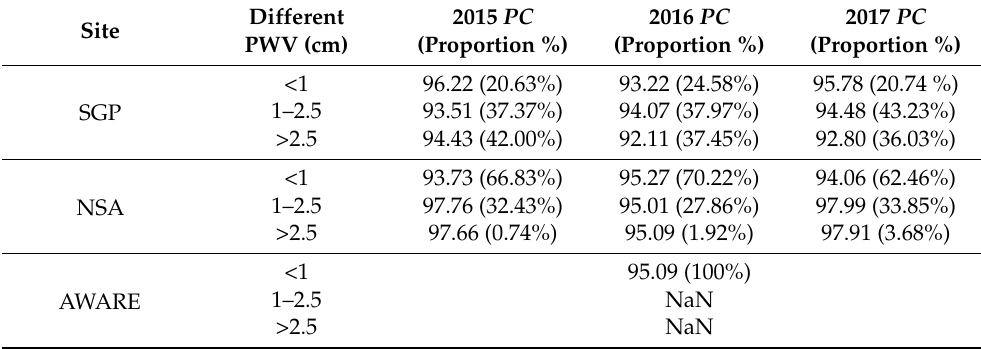
Table 7. Consistency between the cloud detection results derived by AERI and ceilometer at different sites under different PWV ranges. The percentage in parentheses indicates the proportion between the data in the selected PWV range and the total data in the corresponding years of different